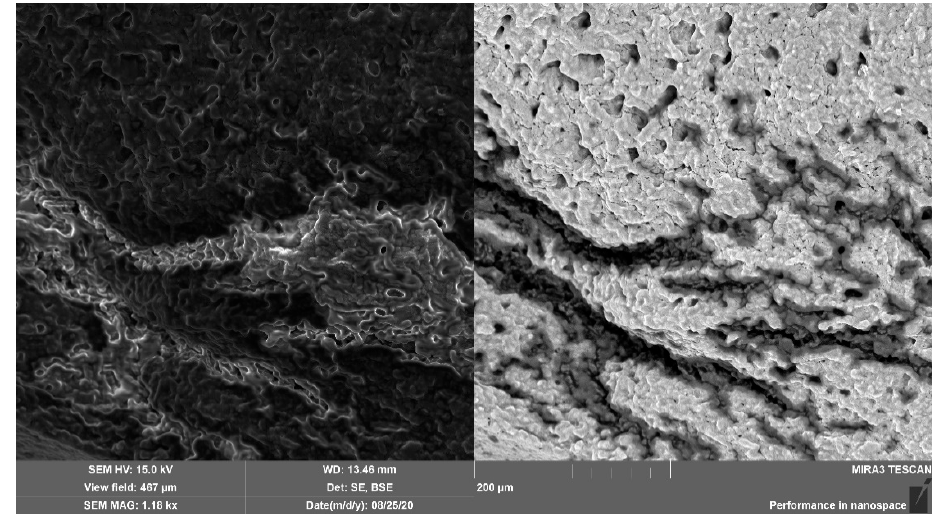
Figure 1. Scanning electron microscope (SEM) images of the obtained nanoemulgel NG-Carb-1.0.